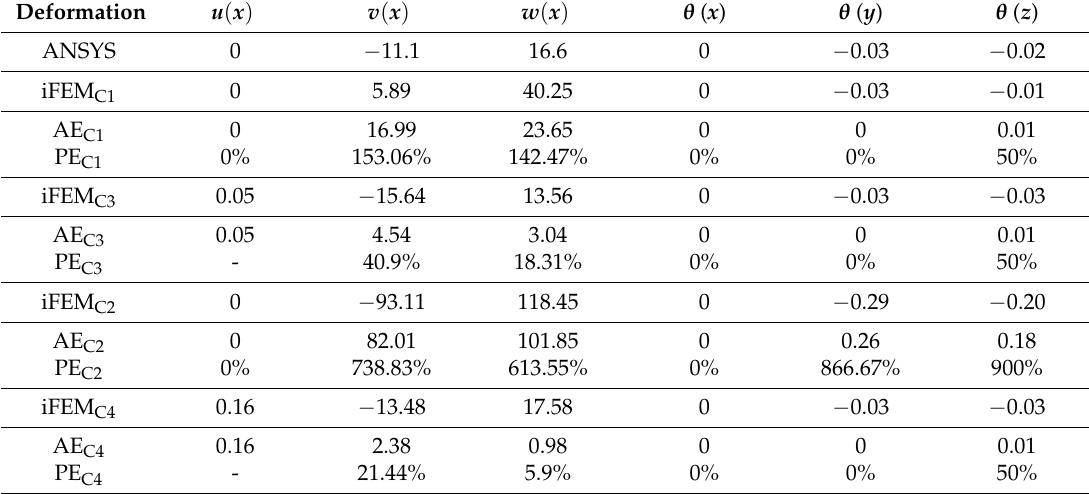
Table 6. Comparisons among deformations computed with iFEM and deformations extracted from ANSYS in case of uniform distribution loads (Loading B). Strain inputs contained errors.